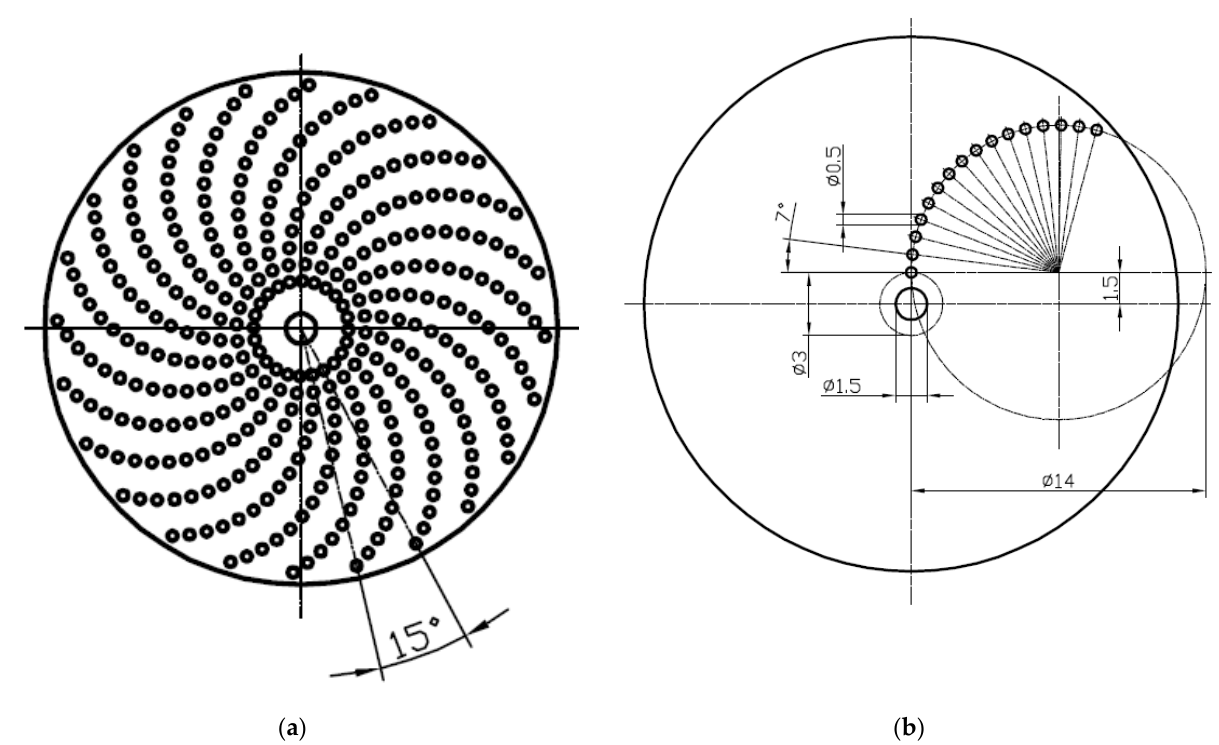
Figure 8. Drawing of the laser cut mask ( a ) and the dimensions of texture ( b ), all dimensions are in mm. The pit-area ratio of the tested samples was 15%, and dimples were in a spiral array (Figure 9).